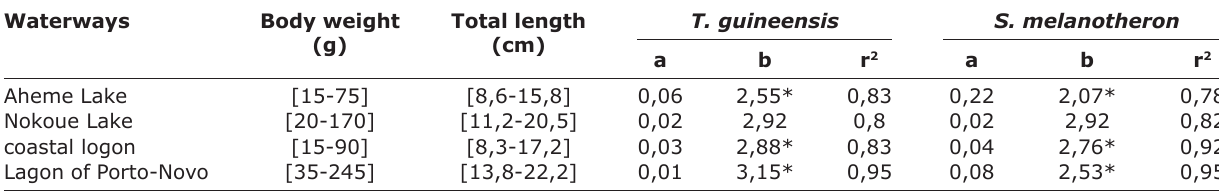
Table-3: Body weight and total length relationship in Tilapia guineensis and Sarotherodon melanotheron in streams in southern Benin. Waterways